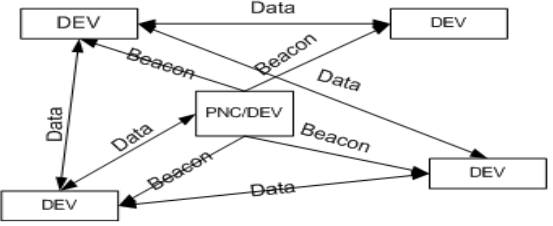
Figure 1. Piconet Structure in IEEE 802.15.3.